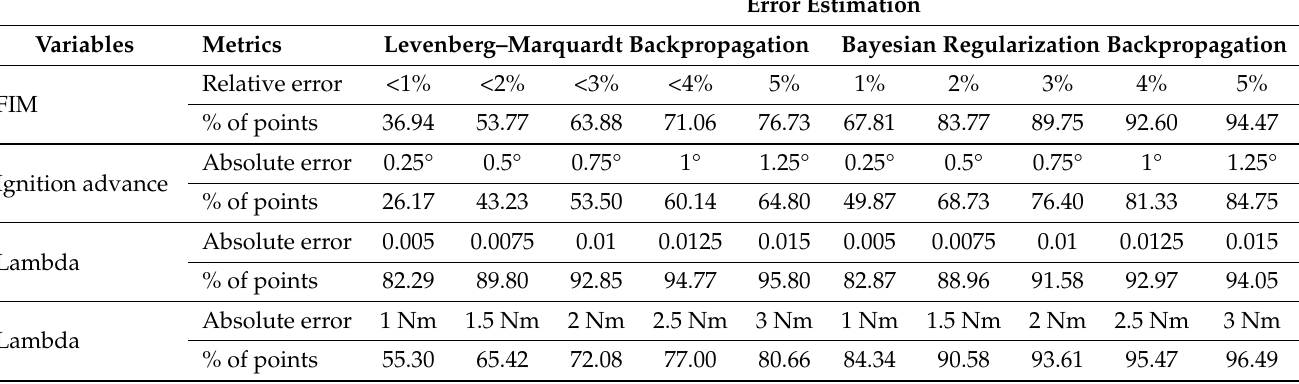
Table 6. Precision of ANN trained with 43% of